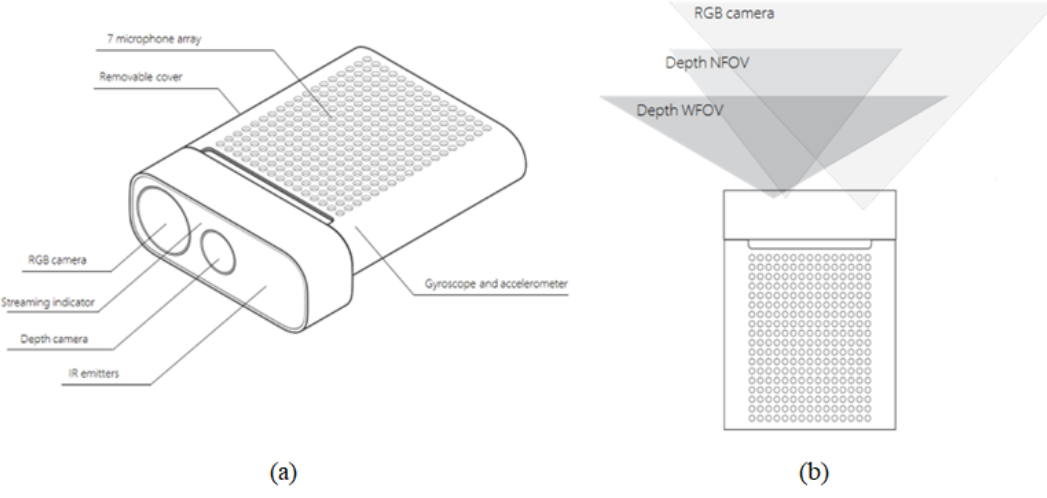
Figure 2. Azure Kinect. ( a ) Azure Kinect configuration; ( b ) Azure Kinect view field. (source: www.